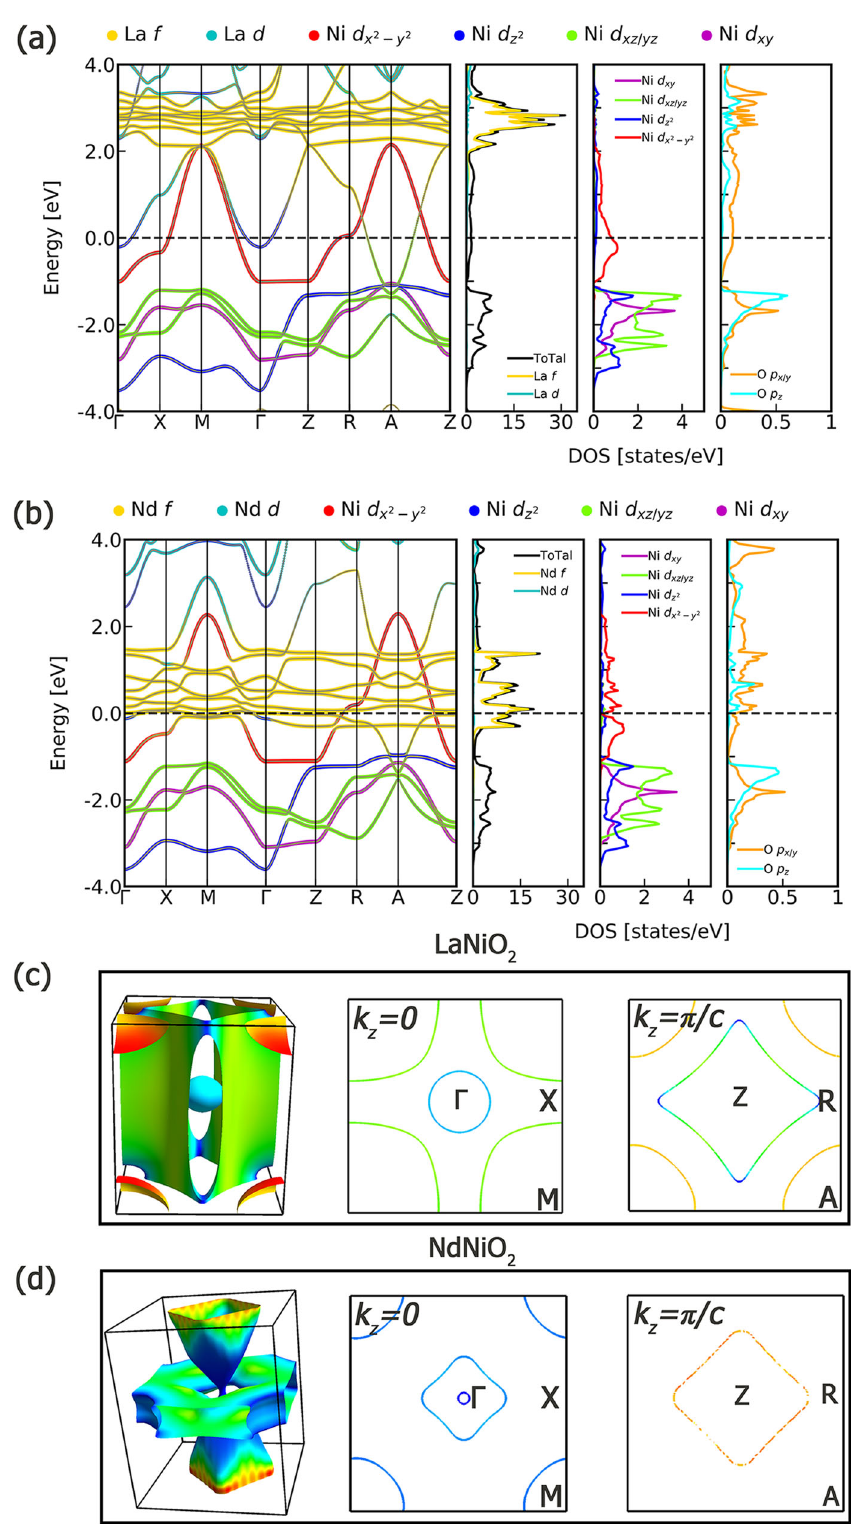
Fig. 2 The calculated electronic structures and Fermi surfaces of non-magnetic (NM) phase. Orbitally-projected electronic structures of NM phase of a LaNiO 2 and b NdNiO 2 . c The calculated Fermi surface of LaNiO 2 and the projection of Fermi surface on k z = 0 and π / c plane. d Same as c but for NdNiO 2 . Red and blue colors identify portions of the Fermi surface where the Fermi velocity is maximum and minimum, respectively. The Fermi velocity lies in- between the maxima and minima in the green